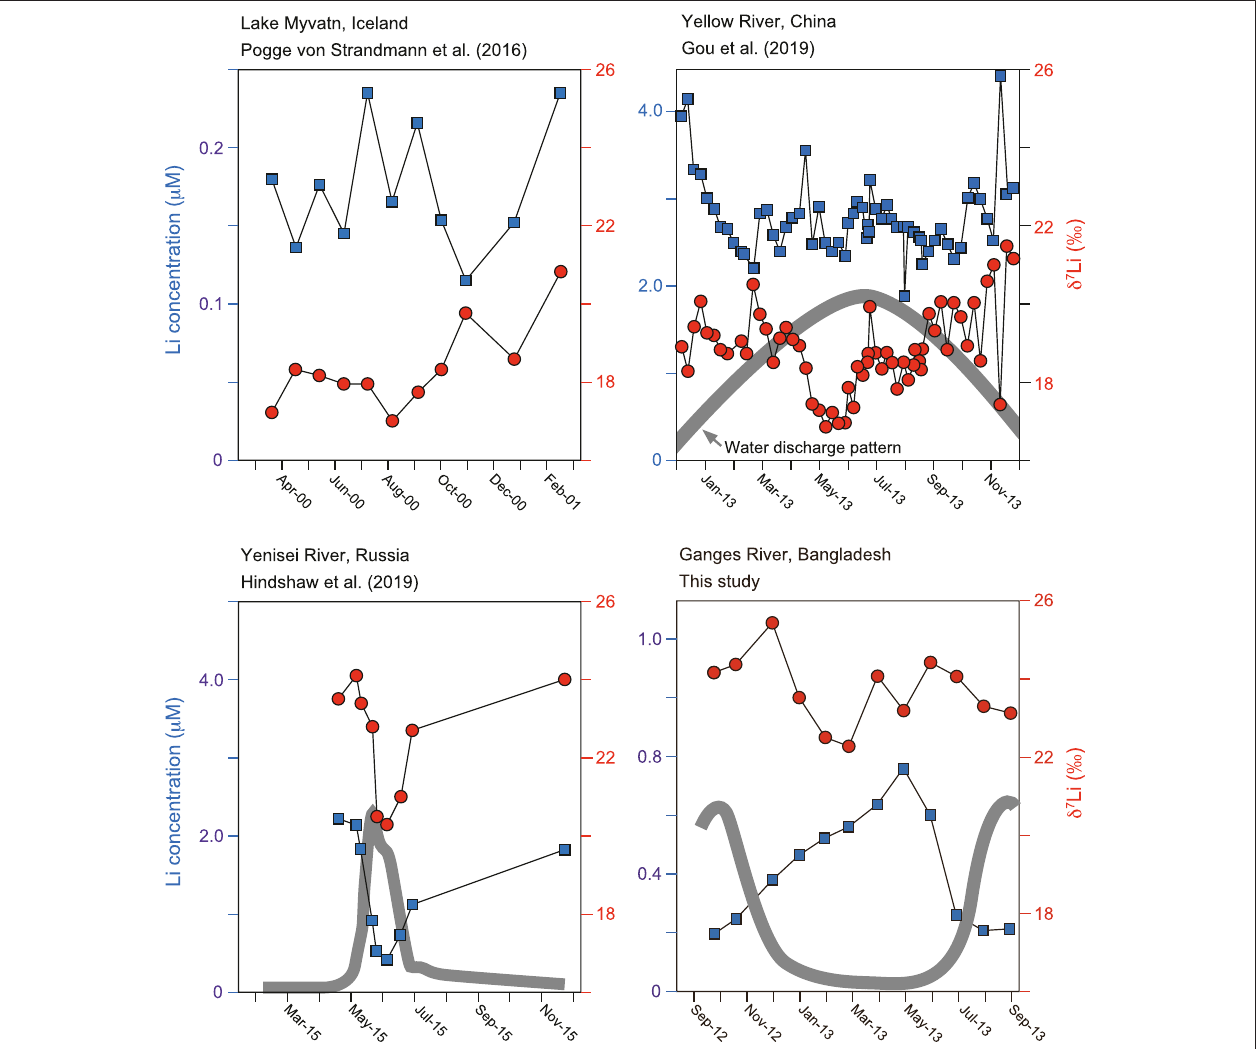
FIGURE 6 | The monthly/weekly time series of dissolved Li of river water samples. Compilation of δ 7 Li values from Pogge von Strandmann et al. (2016), Gou et al. (2019), Hindshaw et al. (2019b) and this study.